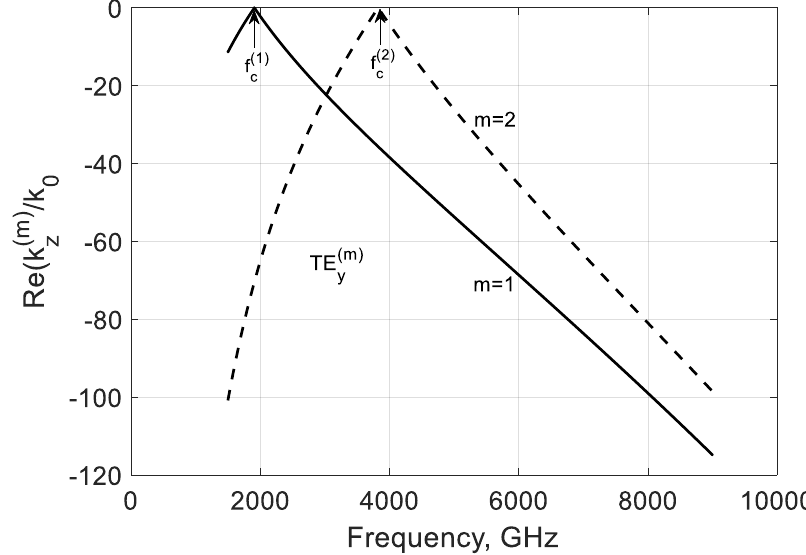
Figure 5. Normalized real parts of the modal propagation constants 0 m z k k of the first two m y TE backward modes of a graphene H-waveguide of the height b = 0.04 mm, width 2 a = ∞ , ε r = 3.84 , and µ σ τ = 1 ps. r = 1. Parameters used for calculation of g are from Ref. [21]: T = 300 K, E F = 40 meV, and